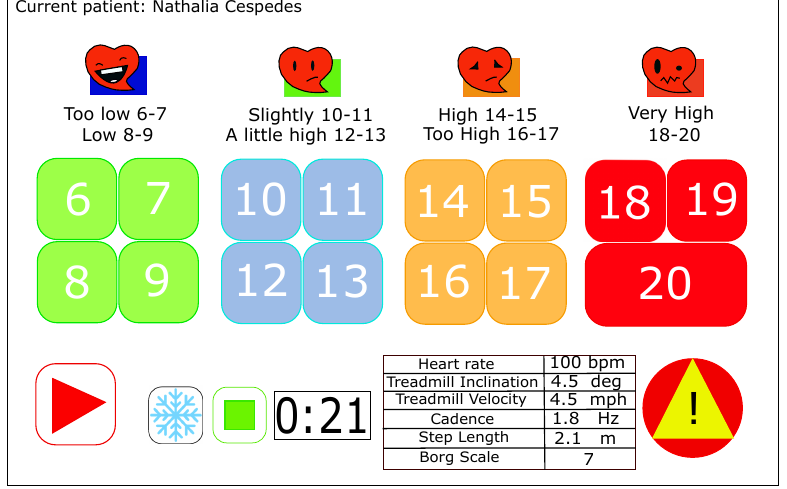
Figure 4. Graphical user interface (GUI) for cardiac rehabilitation human–robot